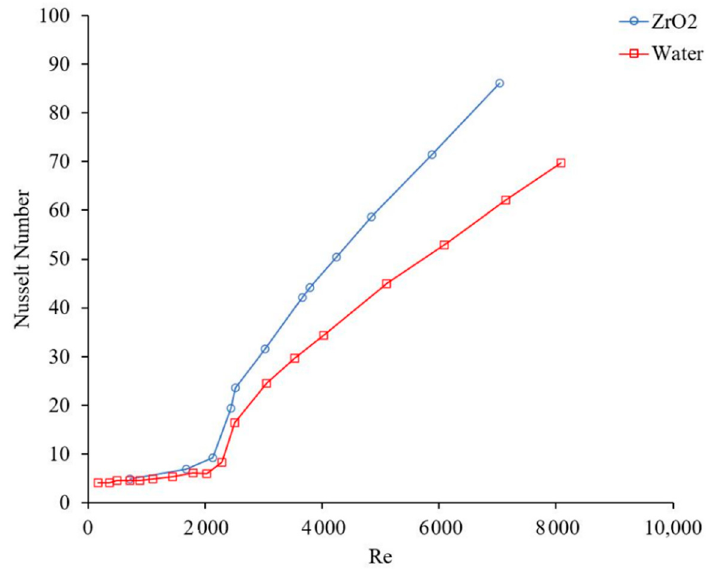
Figure 5. Effect of Reynolds number on heat transfer coefficient, mass concentration 9 wt %, Haghighi et al. [28].